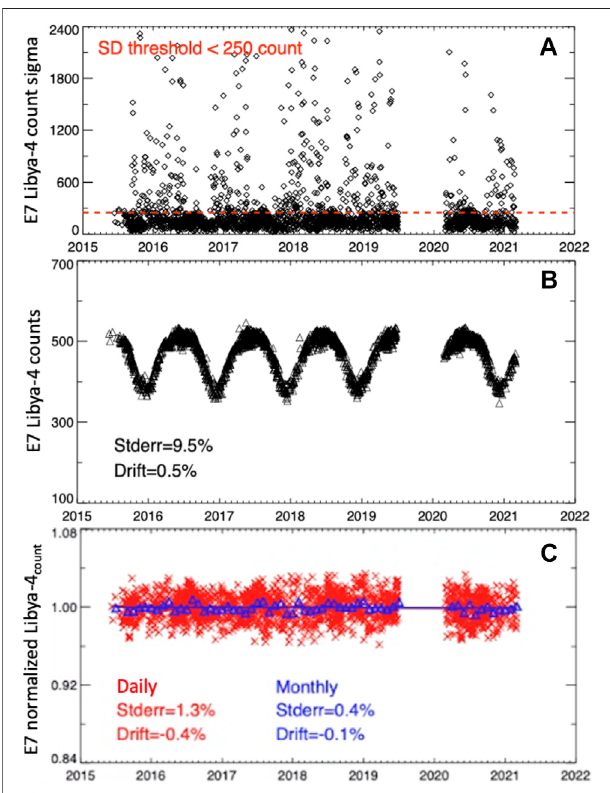
FIGURE 4 | (A) The EPIC E-7 (0.68 µm) daily standard deviation of the countoftheLibya-4ROI(0.6 ° inlatitudeandlongituderegioncenteredat30 ° N and 30 ° E).Thered dashedlinerepresents acountvalueof250.Counts below the red dashed line indicate clear-sky conditions. (B) The E-7 Libya-4 clear-sky dailycounts. Thelinear regressionstandard error and trend(%/year) statisticsarelocatedinthelowerleftcorner (trendlinenotshown). (C) TheE-7 Libya-4 count daily (red x and red solid line) and monthly mean (blue open triangles and blue solid line) associated trend lines. The trend line standard error ( Stderr ) in % and drift in %/yr are given at the bottom of the plot.